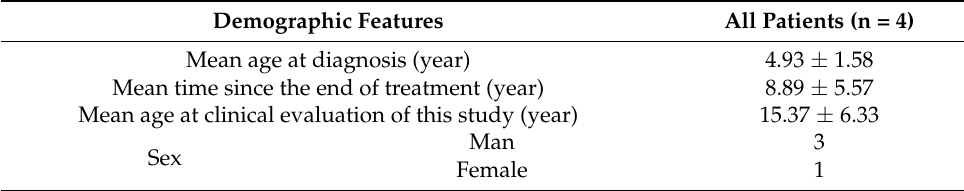
Table 1. Demographic features of study population.